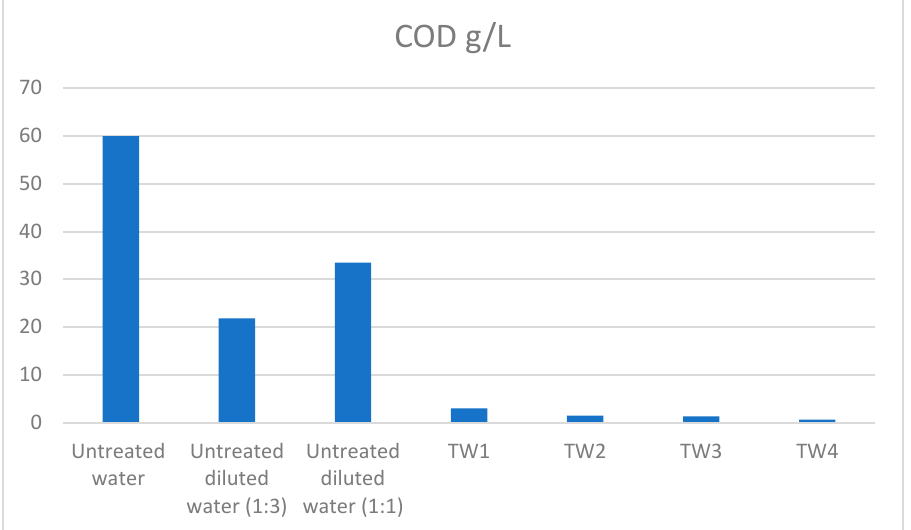
Figure 3. The reduction in the COD values using the different parameters during the wastewater